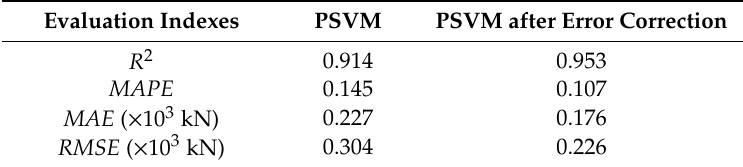
Figure 8. Measured and estimated N u values obtained from the original PSVM model and error corrected PSVM model in the test set. Table 4. Prediction performance comparison of the original PSVM model and error corrected PSVM model in the test set.